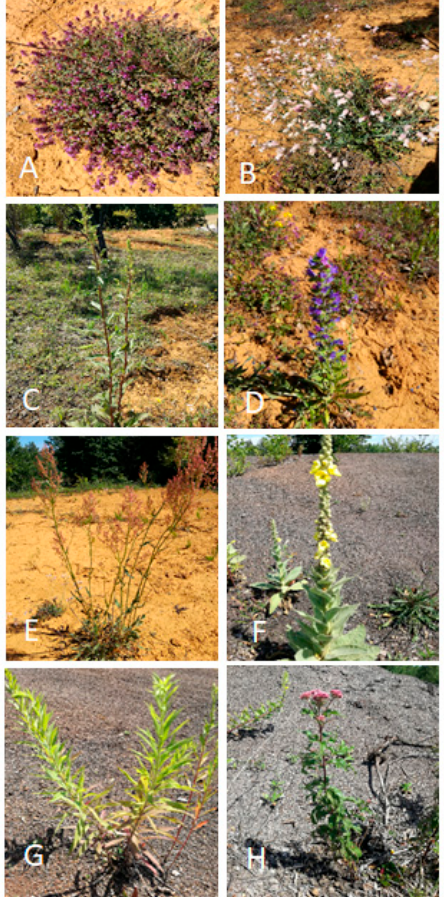
Figure 7. Plant species growing on FW and SW sites, selected for soil and plant sampling: Flotation waste—( A ) T. serpyllum , ( B ) S. vulgaris , ( C ) S. virgaurea , ( D ) E. vulgare , ( E ) R. acetosa , Slag waste—( F ) V. thapsus , ( G ) S. gigantea , ( H ) E. cannabinum.